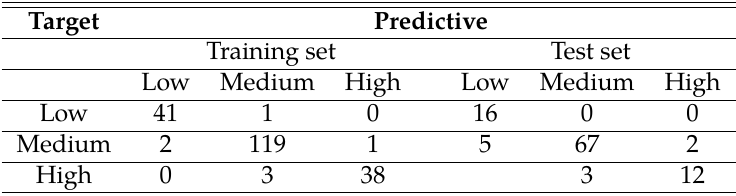
Table 6: Confusion Matrix regarding ANN model for Employees’ Satisfaction